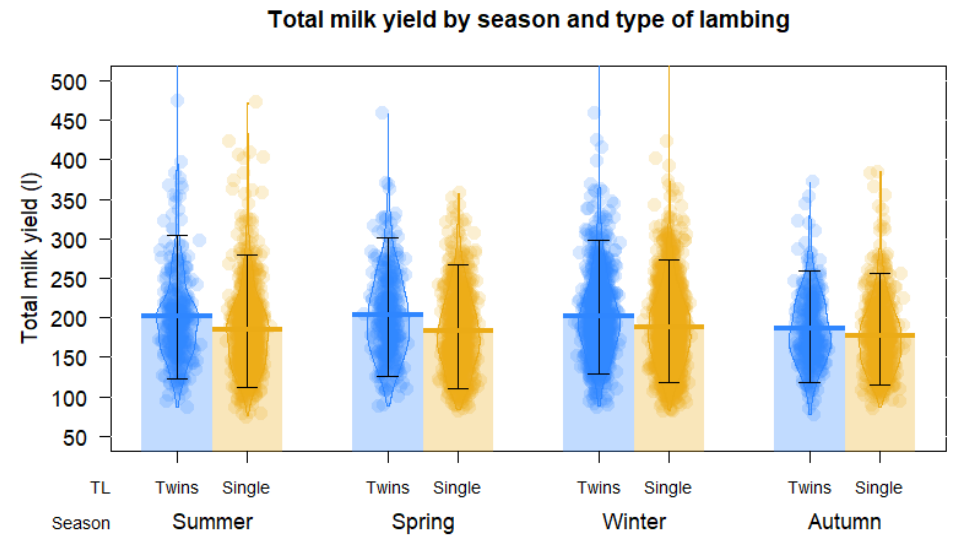
Figure 3. Pirate plot of the e ff ect of litter size (TL) and season of lambing on total milk yield of dairy sheeep from a commercial flock in Spain (points represent the raw data; bar / line is the descriptive statistic (mean); bean is the smoothed density curve showing the full data distribution; and brackets represent the confidence intervals).